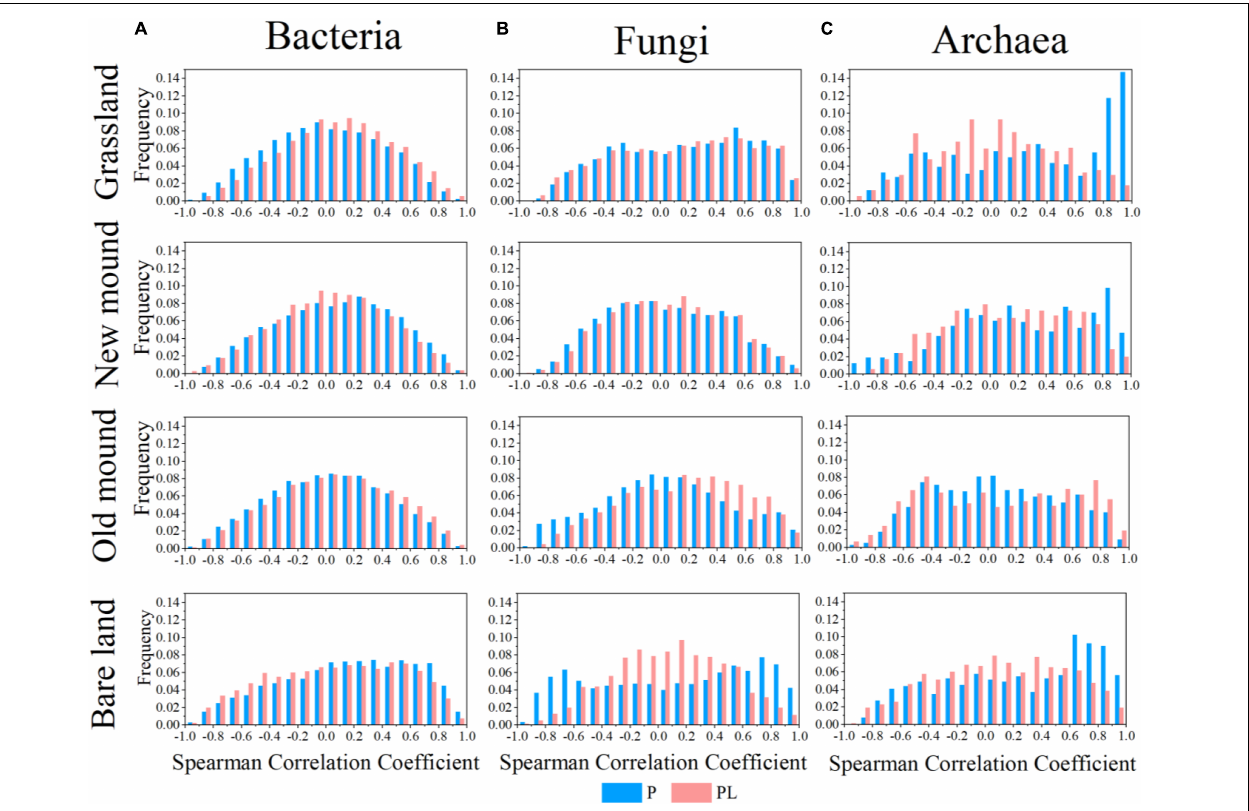
FIGURE 5 | Frequency distributions of all correlations in the bacterial (A) , fungal (B) , and archaeal (C) networks in the grassland, new mound, old mound, and bare land (top to bottom) based on Spearman’s rank correlation test. P (blue), pika disturbance; PL (pink), grazing and pika